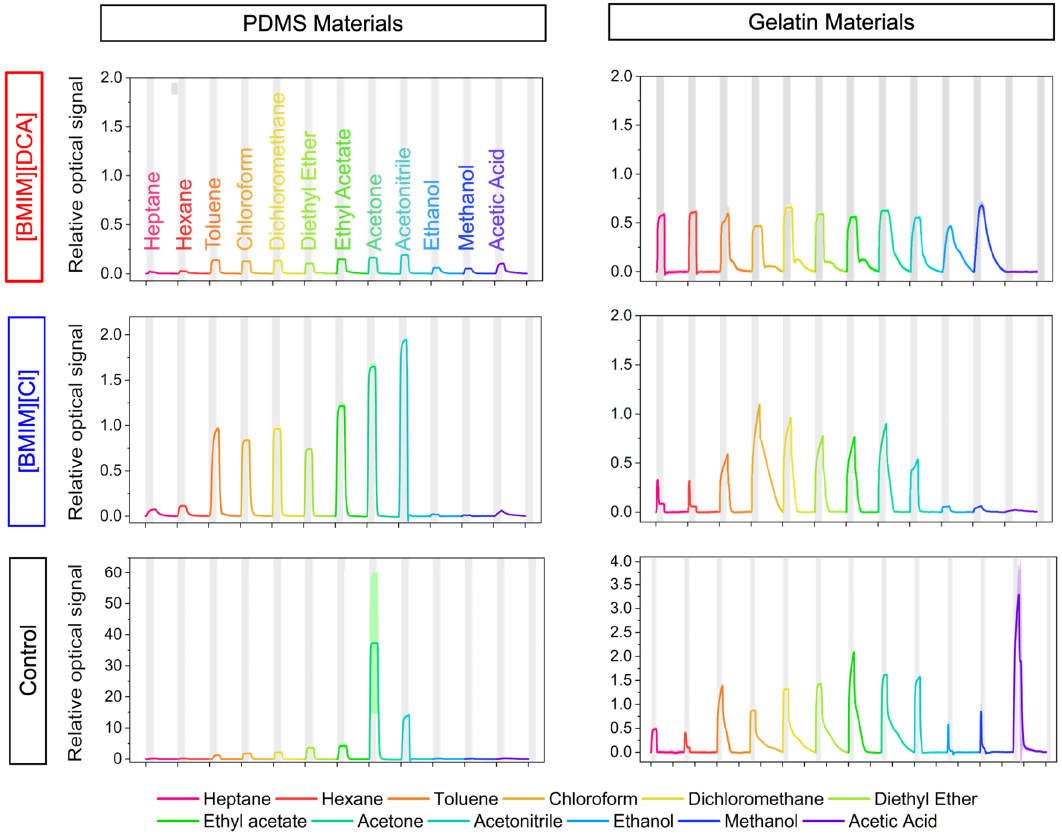
Figure 5. Representative signals of the optical amplitude responses of all hybrid gels and control gels studied. The typical profile of the signals obtained during the exposure and recovery cycles in the optical e-nose. The plots were generated by python.